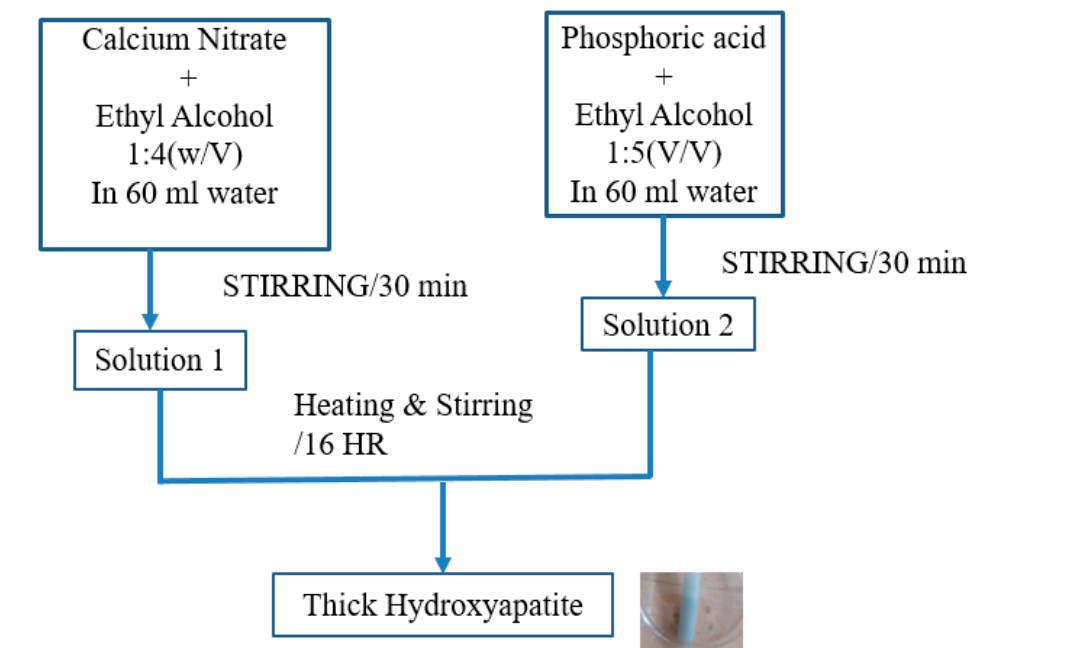
Figure 2. Schematic preparation of HA gel by sol-gel process.